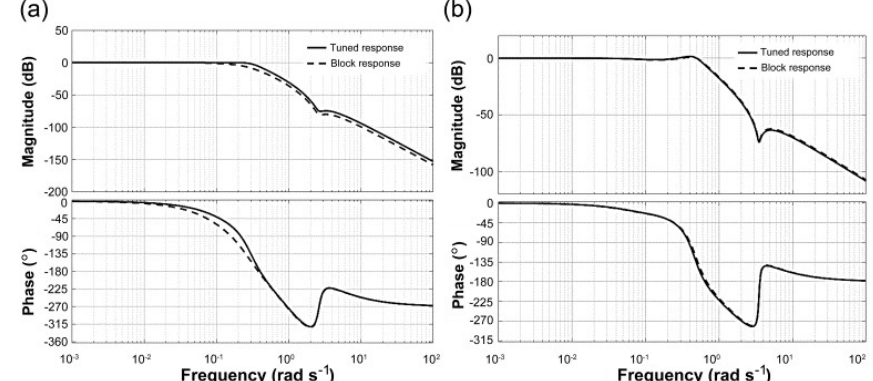
Figure 21. (a) Stability Analysis using Bode Plot with Respect to Reference Tracking for 2% Changes in T in and (b) Stability Analysis using Bode Plot with Respect to Reference Tracking for 15% Changes in T in .